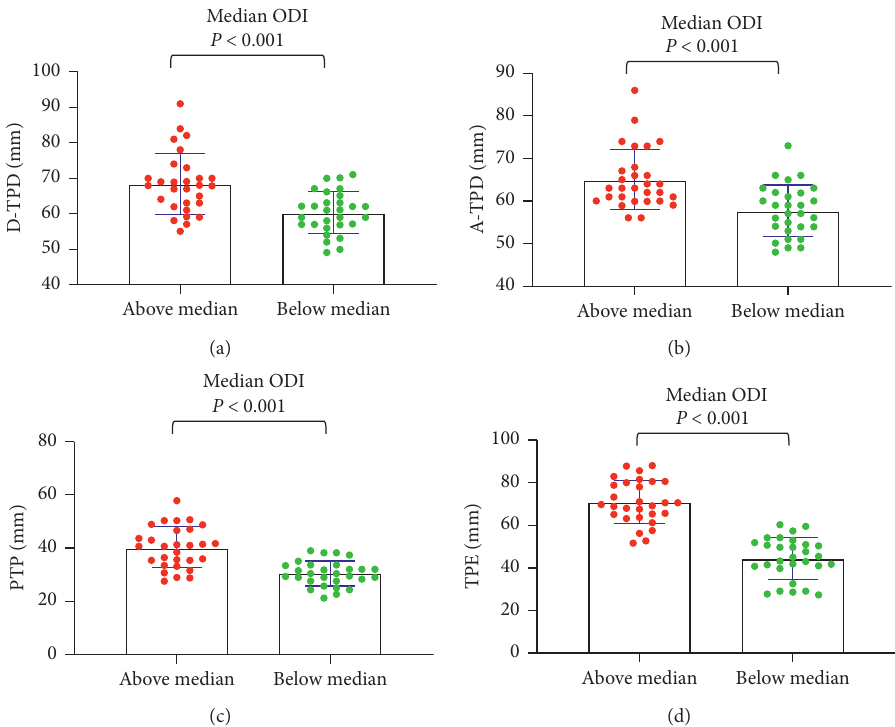
Figure 5: Tactile acuity for median ODI in the abovemedian group versus the belowmedian group. (a) D-TPD, (b) A-TPD, (c) PTP, and (d) TPE. The median of ODI was 21.5. D-TPD � two-point discrimination test performed in a descending manner; A-TPD � two-point discrimination test performed in an ascending manner; PTP � point-to-point test; TPE � two-point estimation; ODI � Oswestry Disability Index.